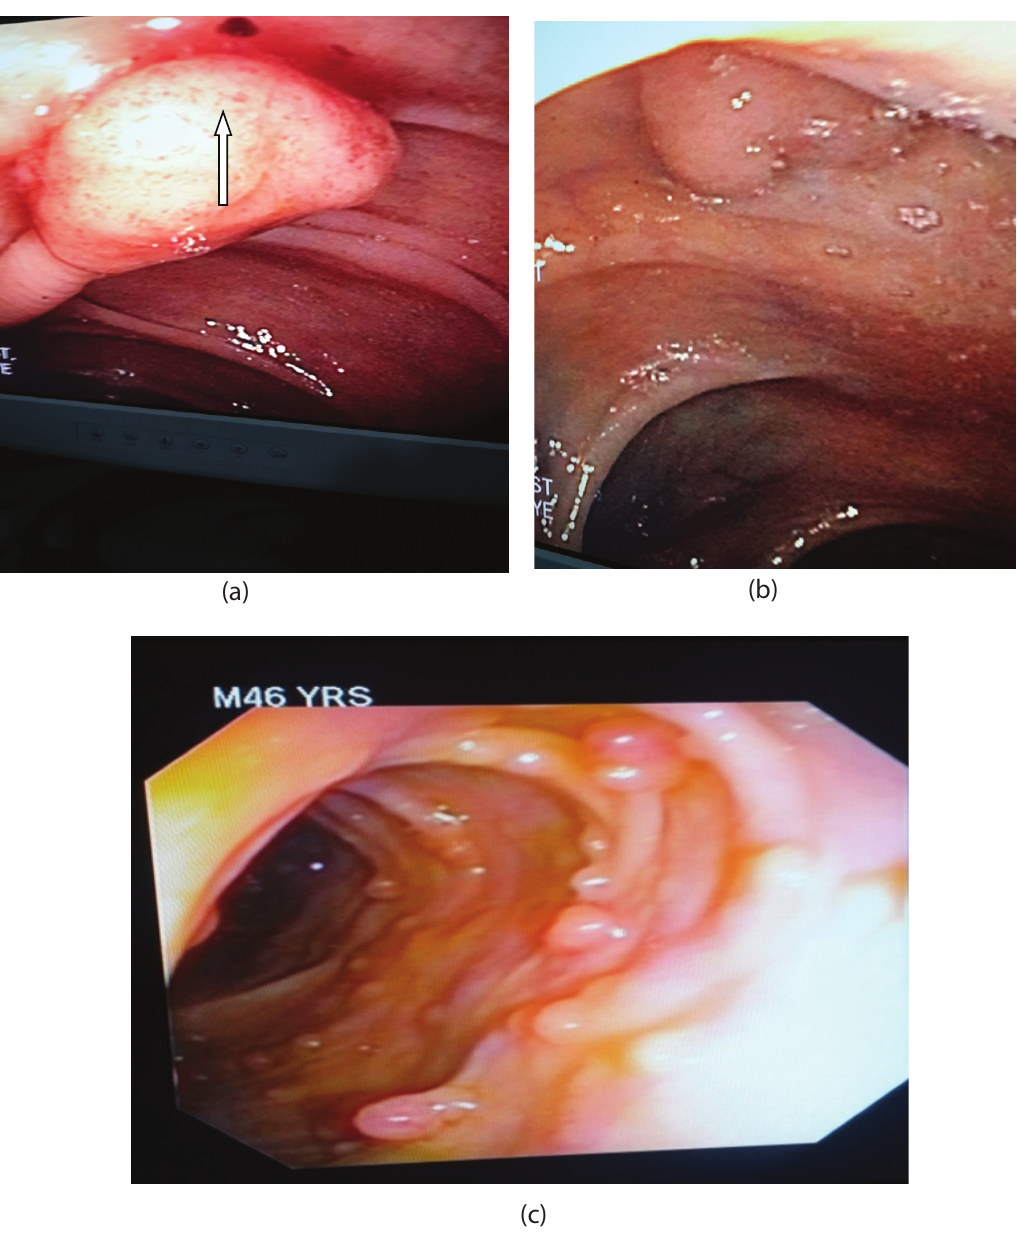
Figure 1: (a): A pedunculated polyp with its stalk. (b): A sessile polyp with a broad base. (c): Familial Adenomatous Polypsis with hundreds of